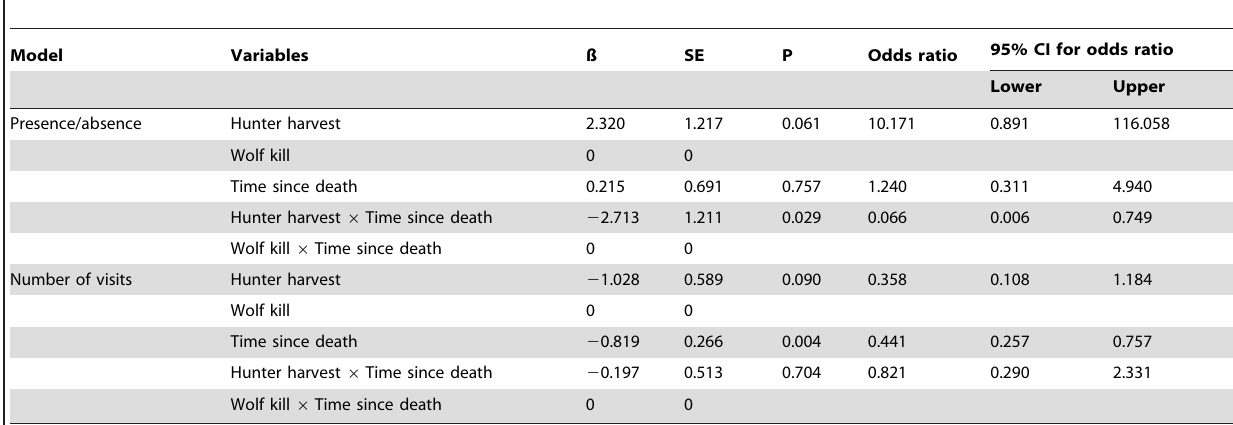
Table 5. Parameter estimates (ß) of cause of death (hunter harvest (n=11) or wolf kill (n=11)) and time since death (ten-day periods (n=63)) and their interactions on presence/absence and number of visits by any scavenging species (all species pooled).